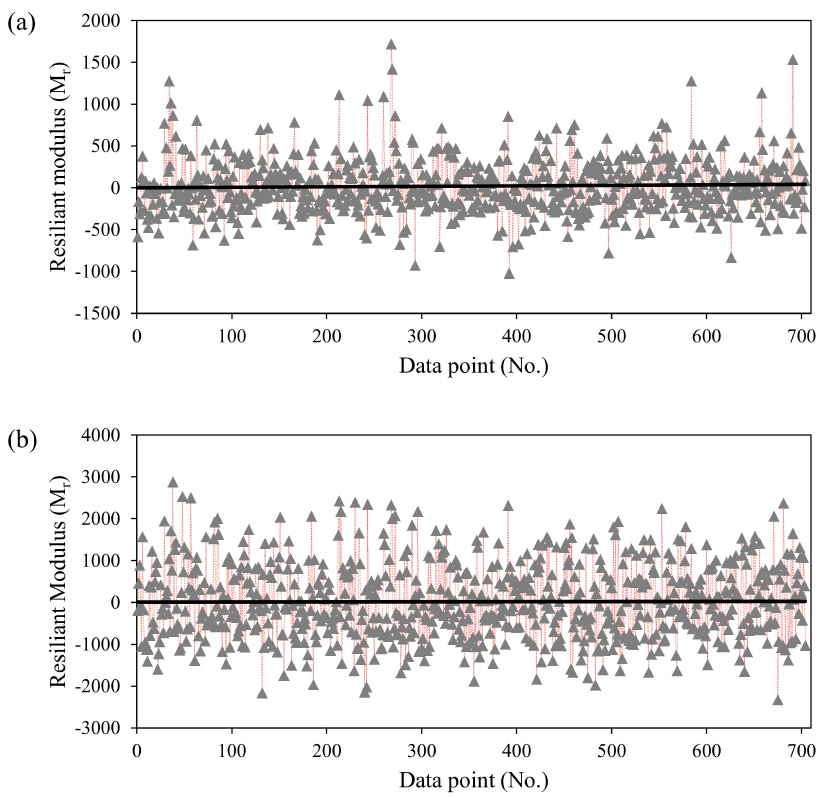
Figure 4. Error analysis of the proposed models: ( a ) ANN; ( b )